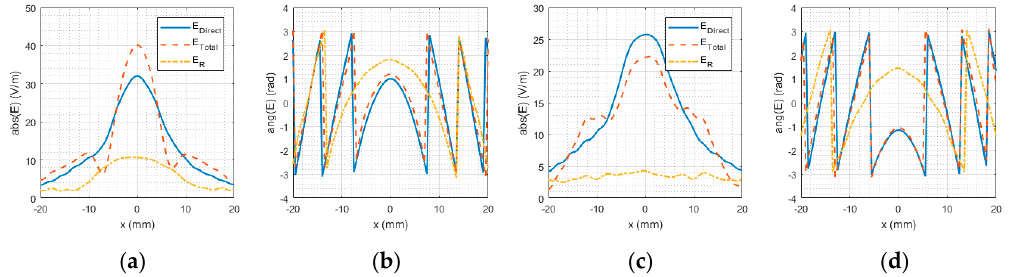
Figure 9. Cross-section of the x component of 𝐄 (cid:2904)(cid:2925)(cid:2930)(cid:2911)(cid:2922) , 𝐄 (cid:2888)(cid:2919)(cid:2928)(cid:2915)(cid:2913)(cid:2930) , and 𝐄 (cid:2902) at d = 7.25 mm (TPD local maximum): ( a ) magnitude; ( b ) phase and at d = 9.0 mm (TPD local minimum): ( c ) magnitude; ( d ) phase. ( d )